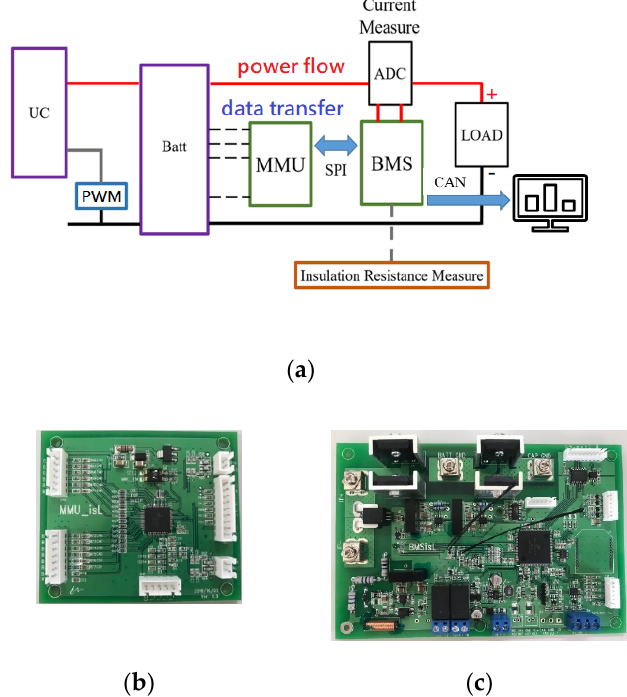
Figure 2. In-house battery management system: ( a ) basic diagram; ( b ) board of module monitoring unit (MMU), based on chip ISL78600; ( c ) operation board of BMS.